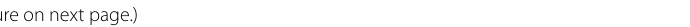
figure on next Fig. 2 Phylogenetic tree indicating the placement of Escovopsis (brown branches), Sympodiorosea (pink branches) and Luteomyces (yellow branches) within the Hypocreales . The tree shown was inferred using Bayesian Inference (BI). Highlighted clades in different colours represent six different families ( Bionectriaceae, Clavicipitaceae, Cordycipitaceae, Hypocreaceae, Nectriaceae , and Ophiocordycipitaceae ) in the Hypocreales . The analysis was based on concatenated sequences of LSU, tef 1, rpb 1 and rpb 2 (See Additional file 1: Table S5 for all strains and their associated metadata used to infer this phylogenetic tree). Numbers on branches indicate BI posterior probabilities (PP) and Maximum Likelihood bootstrap support values (MLB), respectively. Hyphens (--) indicate MLB < 70%. We used eight species from the family Stachybotryaceae (dark green box) to root the tree. ET indicates ex-type